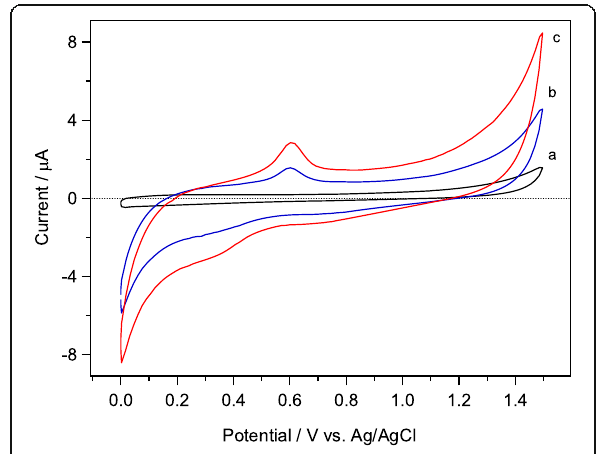
Fig. 7 Cyclic voltammograms measured in 0.1 M PBS (pH 7) at a scan rate 50 mVs − 1 in the presence of 5 mM ethanol on a bare GCE, b mesoporous Fe 2 O 3 -modified GCE ,and c mesoporous 1 wt.% Ag/Fe 2 O 3 -modified